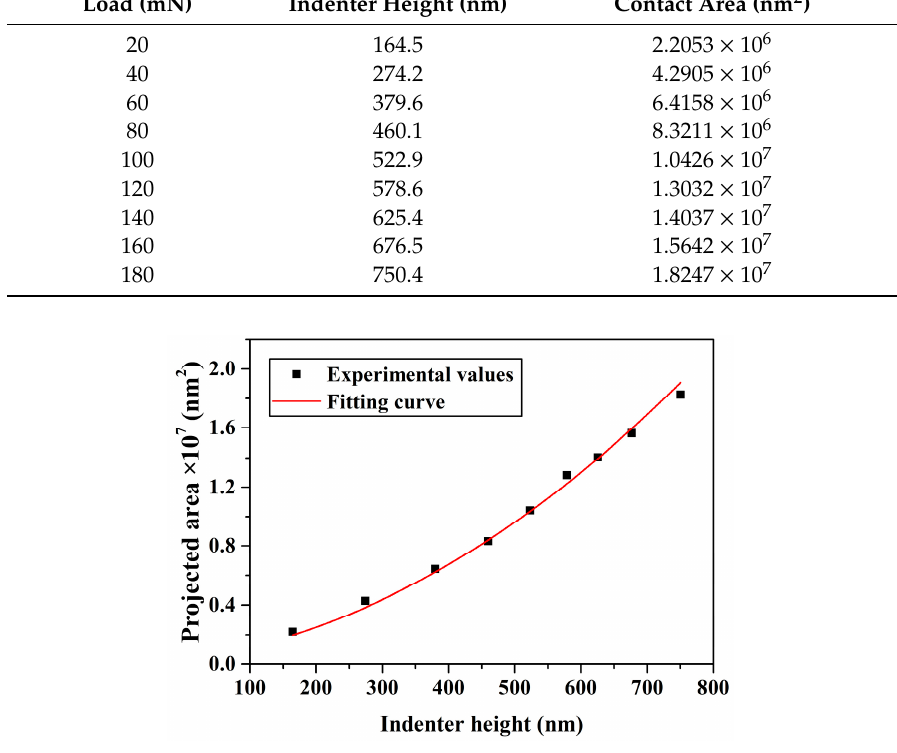
Figure 4. Relationship between the projected area and indenter height. Table 2. Indenter height and contact area for different loads.